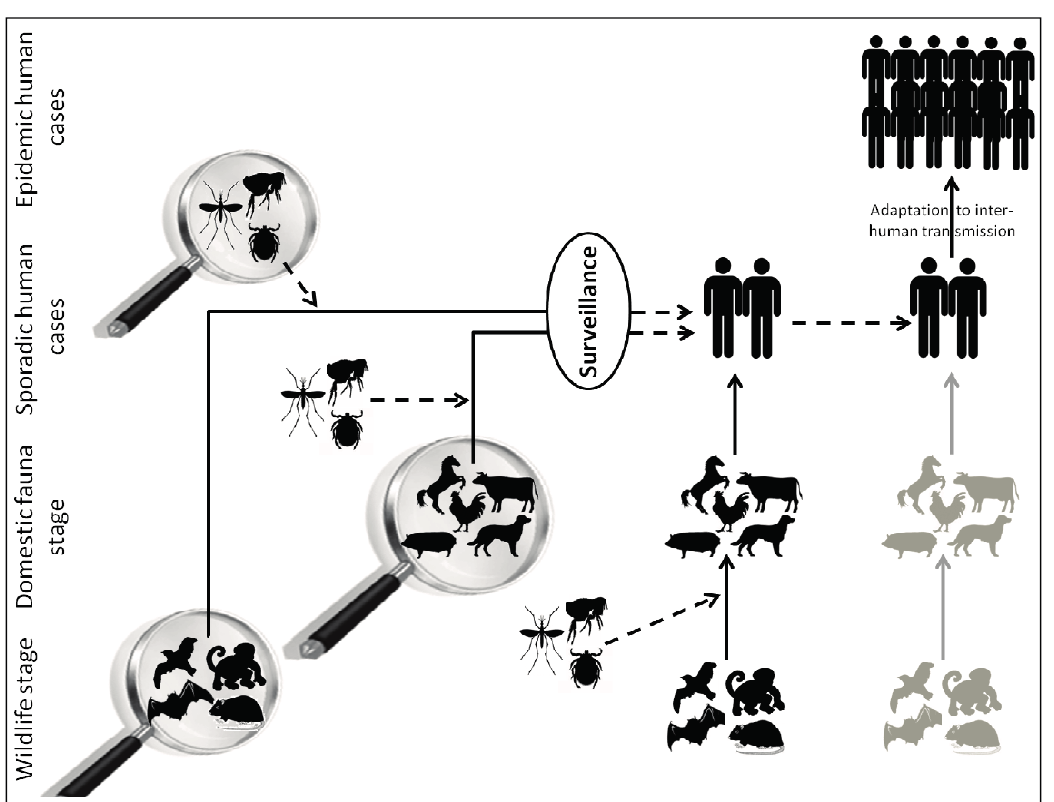
Figure 1. The origins of zoonotic human